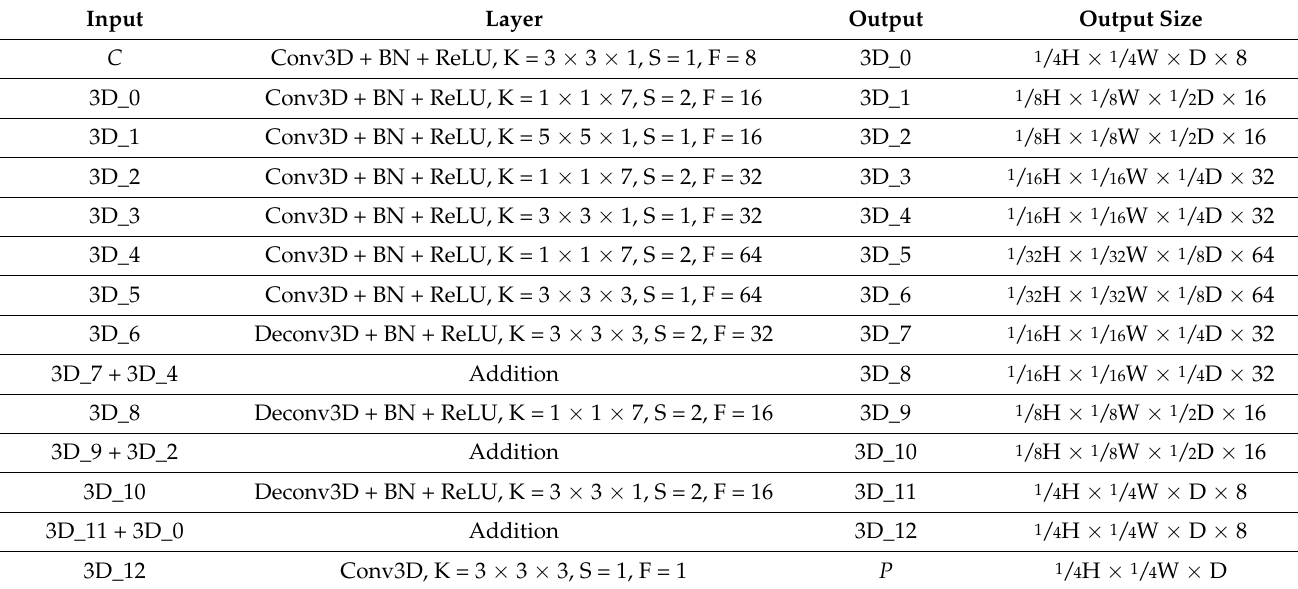
Table 2. Detailed architecture of the 3D